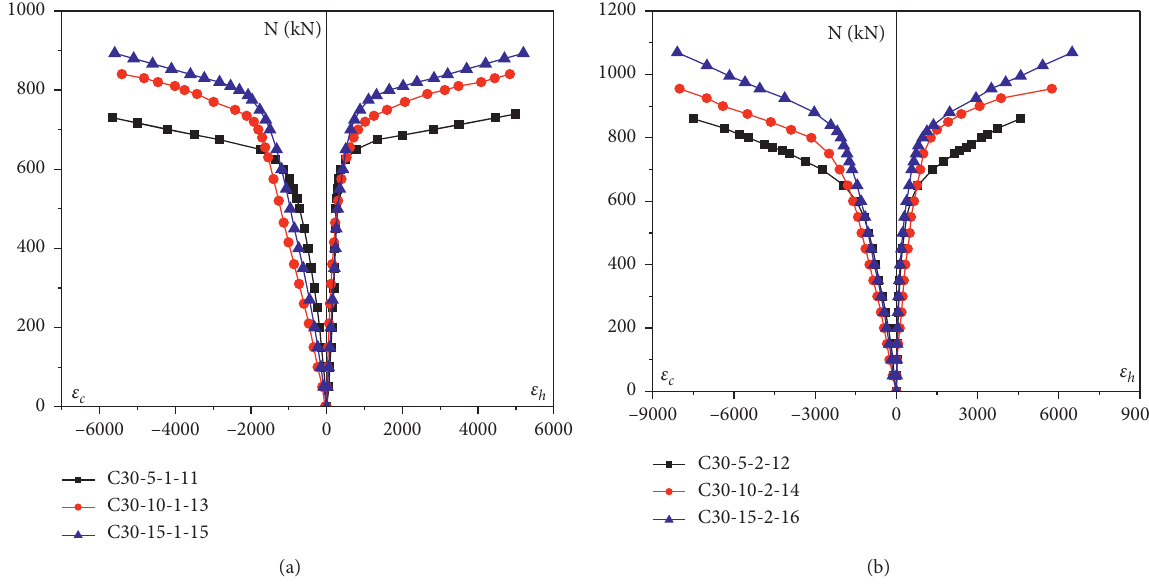
Figure 6: Test load-strain curves. (a) Specimens warped with one-layer CFRP. (b) Specimens warped with two-layer CFRP.